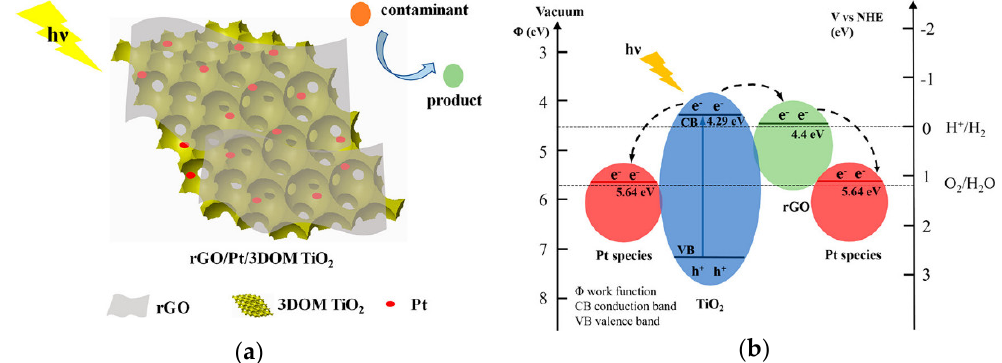
Figure 7. Schematic illustrations of: ( a ) the morphology of TiO 2 IO co-modified with Pt NPs and reduced graphene oxide (r-GO), and ( b ) the proposed charge carriers’ separation and migration in rGO / Pt / TiO 2 (not plasmonic activation); Reprinted with permission from [123]. Copyright (2019) ACS.